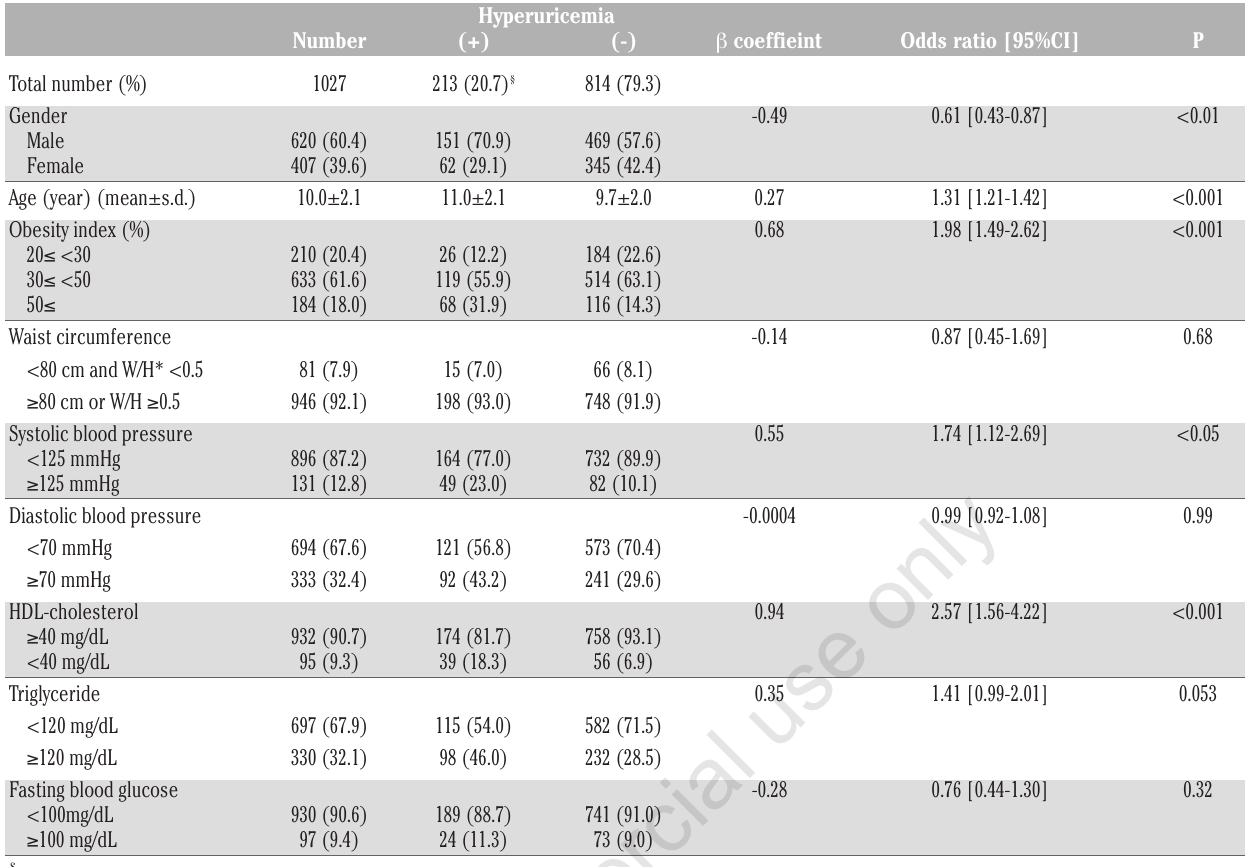
Table 3. Association between hyperuricemia and demographic factors and components of metabolic syndrome.